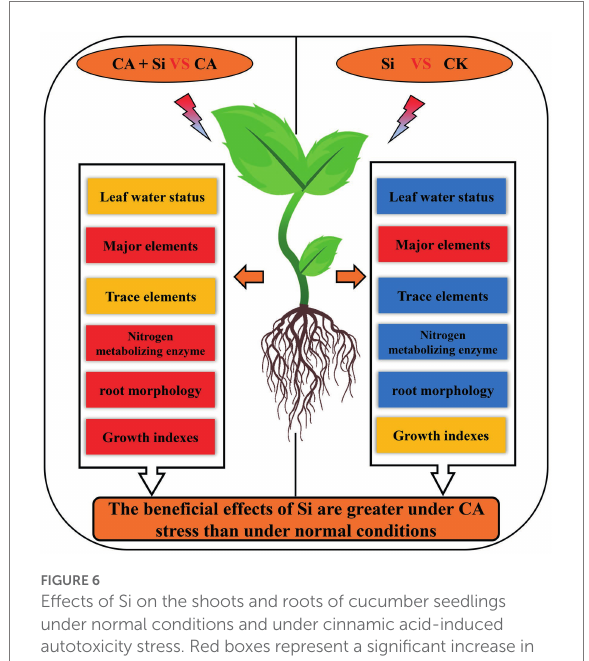
FIGURE 6 Effects of Si on the shoots and roots of cucumber seedlings under normal conditions and under cinnamic acid-induced autotoxicity stress. Red boxes represent a significant increase in all indicators, orange boxes represent significant increases in some indicators, and blue boxes represent no significant increase in any